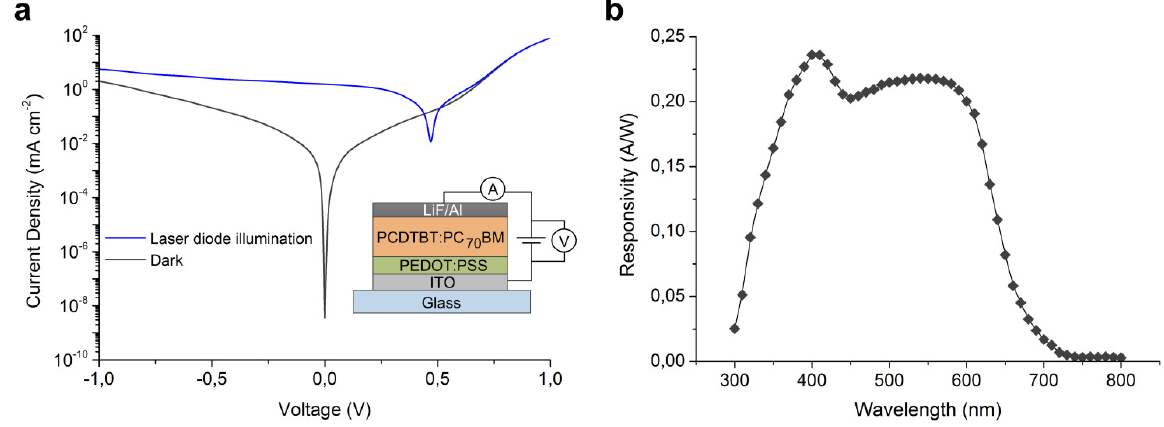
Figure 3. ( a ) J-V curves for the OPD pixel in dark and under laser diode illumination. Inset shows the ITO/PEDOT:PSS/PCDTBT:PC BM/LiF/Al architecture of the OPD pixel. 70 ( b ) Photosensitivity spectral response for the OPD